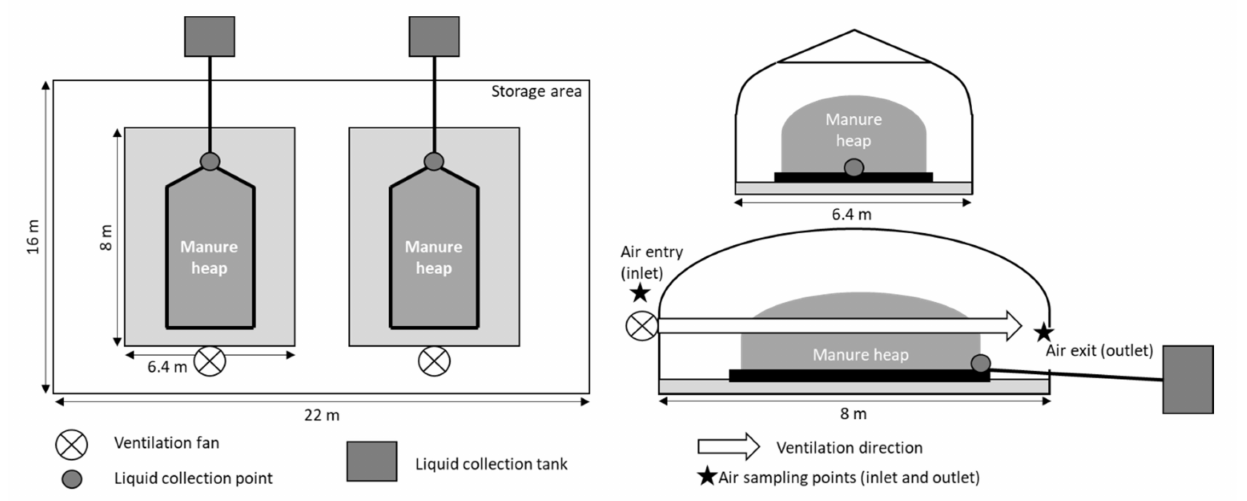
Figure 2. Overhead ( left ), front ( upper right ), and side ( lower right ) views of the experimental storage site (diagrams are not to scale).